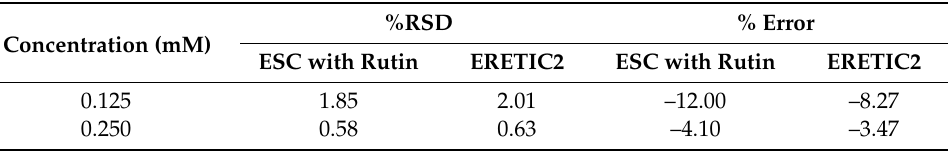
Table 7. The LOQ was established as the concentration with %RSD and % Error < 5 (absolute) in triplicate readings of rutin solutions. The LOQ was determined at 0.250 mM.